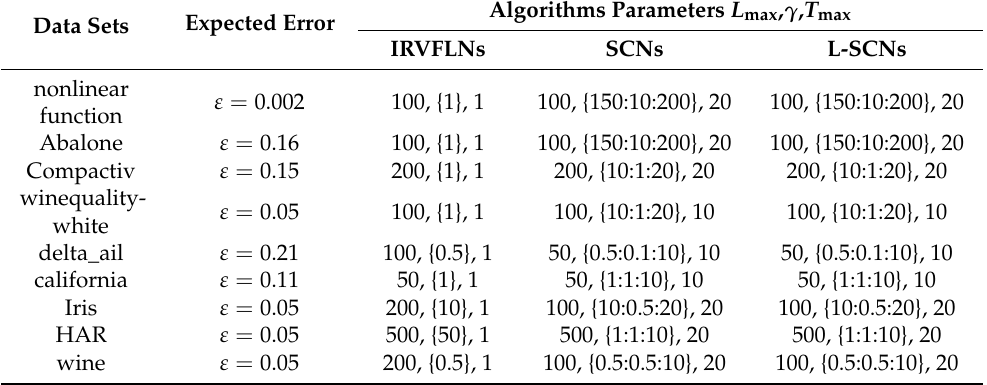
Table 2. Specifications of the experimental setup.